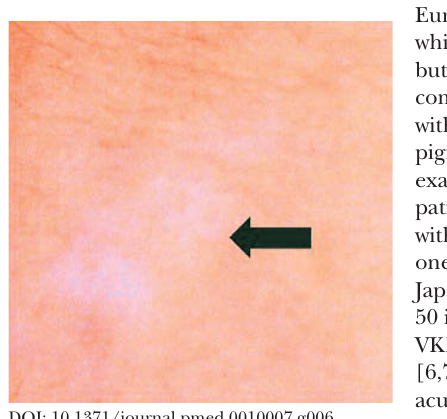
Figure 6. Vitiligo on Skin of Forearm